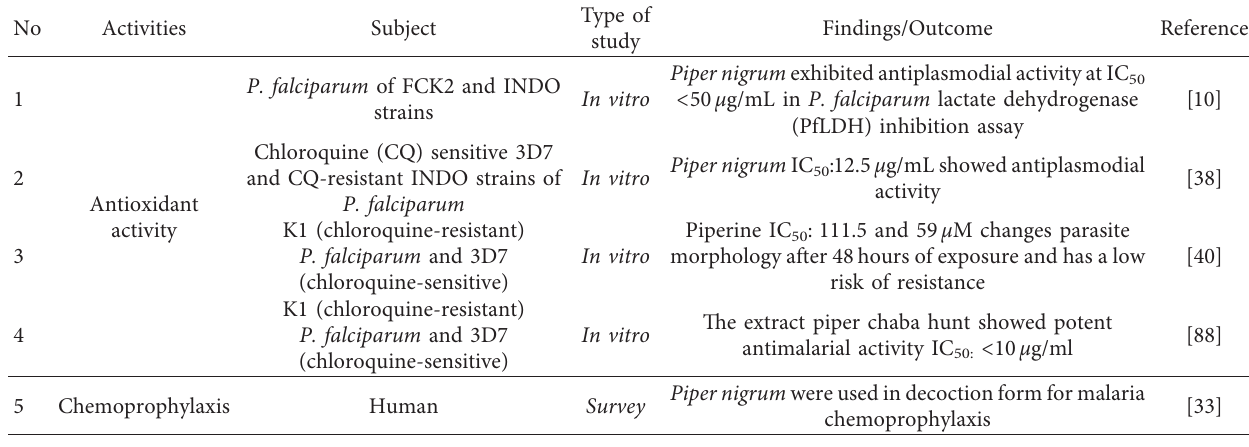
Table 2: Several studies related to piperine as an antiplasmodium.